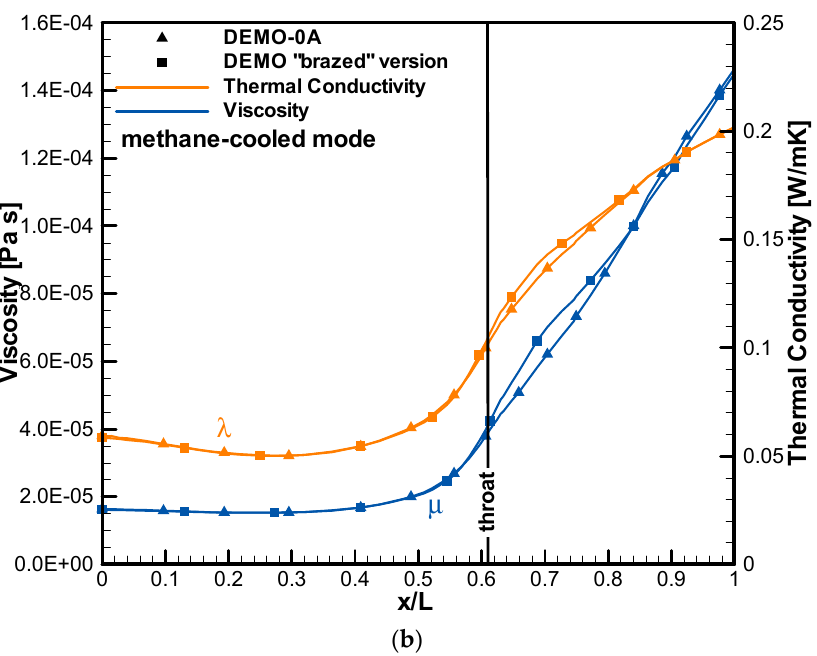
Figure 18. Methane-cooled mode, axial profiles: ( a ) average density and specific heat; ( b ) thermal conductivity and viscosity .